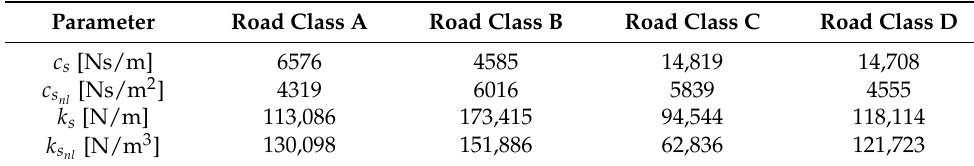
Table 3. Optimal solutions of the four system identification